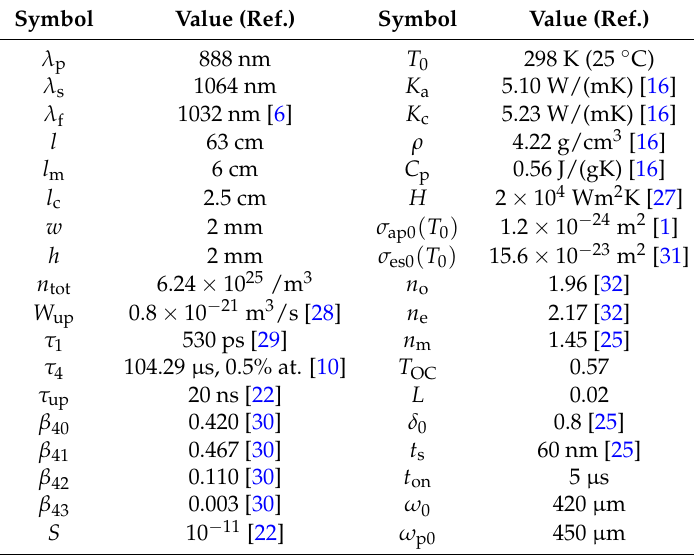
Figure 2. Experimental setup of the dual-rod acousto-optic Q-switched laser systems with the corresponding coordinate frames: LD, laser diode; Xtal, crystal; AOM, acoustic optical modulator; M, mirror; DM, dichroic mirror. Table 1. The parameters used in this